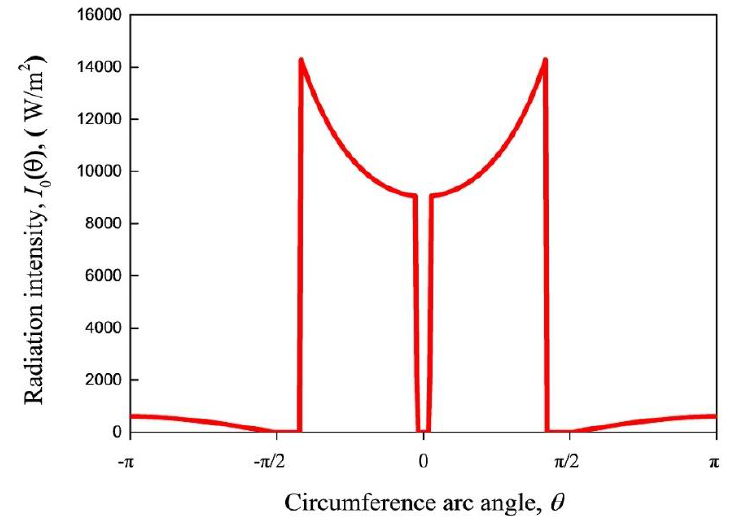
Figure 6. Solar radiation intensity along the circumference of collector